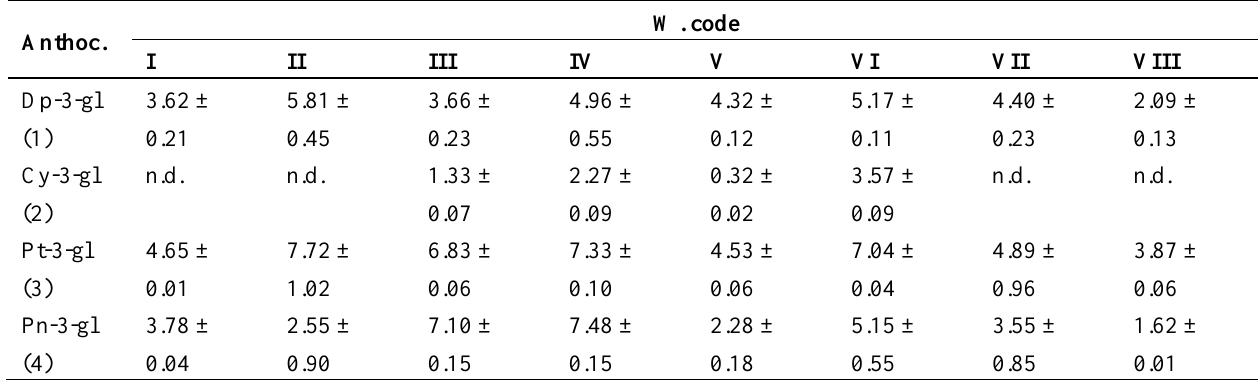
Table 4. Distribution of individual anthocyanins and total anthocyanin contents of the wines samples (% ± SD, n =